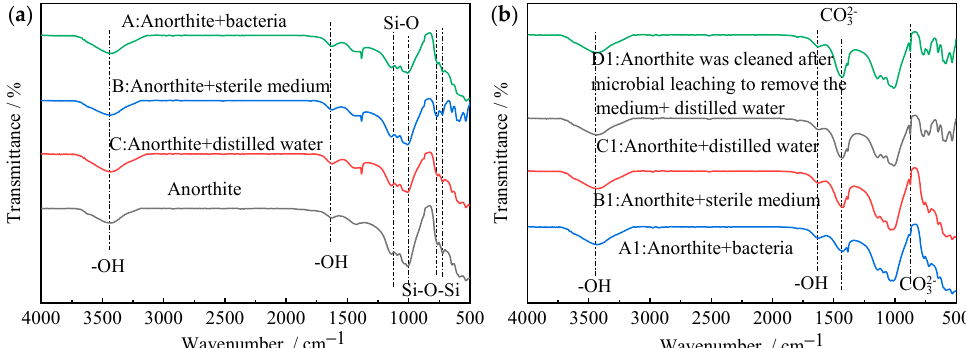
Figure 6. Infrared spectra of anorthite leaching residue ( a ) and carbonation products ( b ).